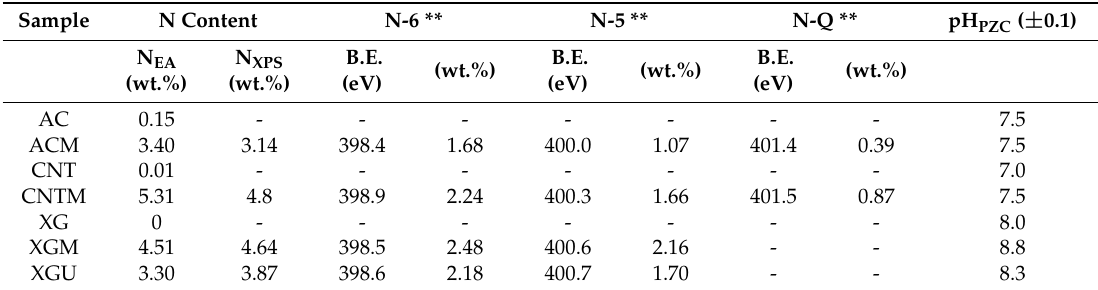
Table 2. Chemical properties of the carbon-based materials *.